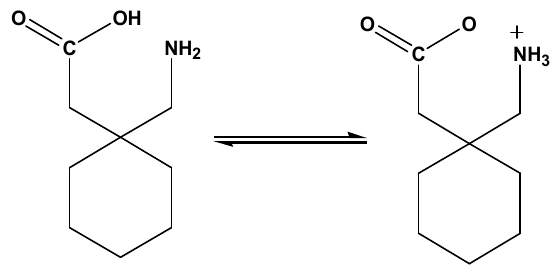
Figure 1. The zwitterion structure of the gabapentin (Gpn) drug.